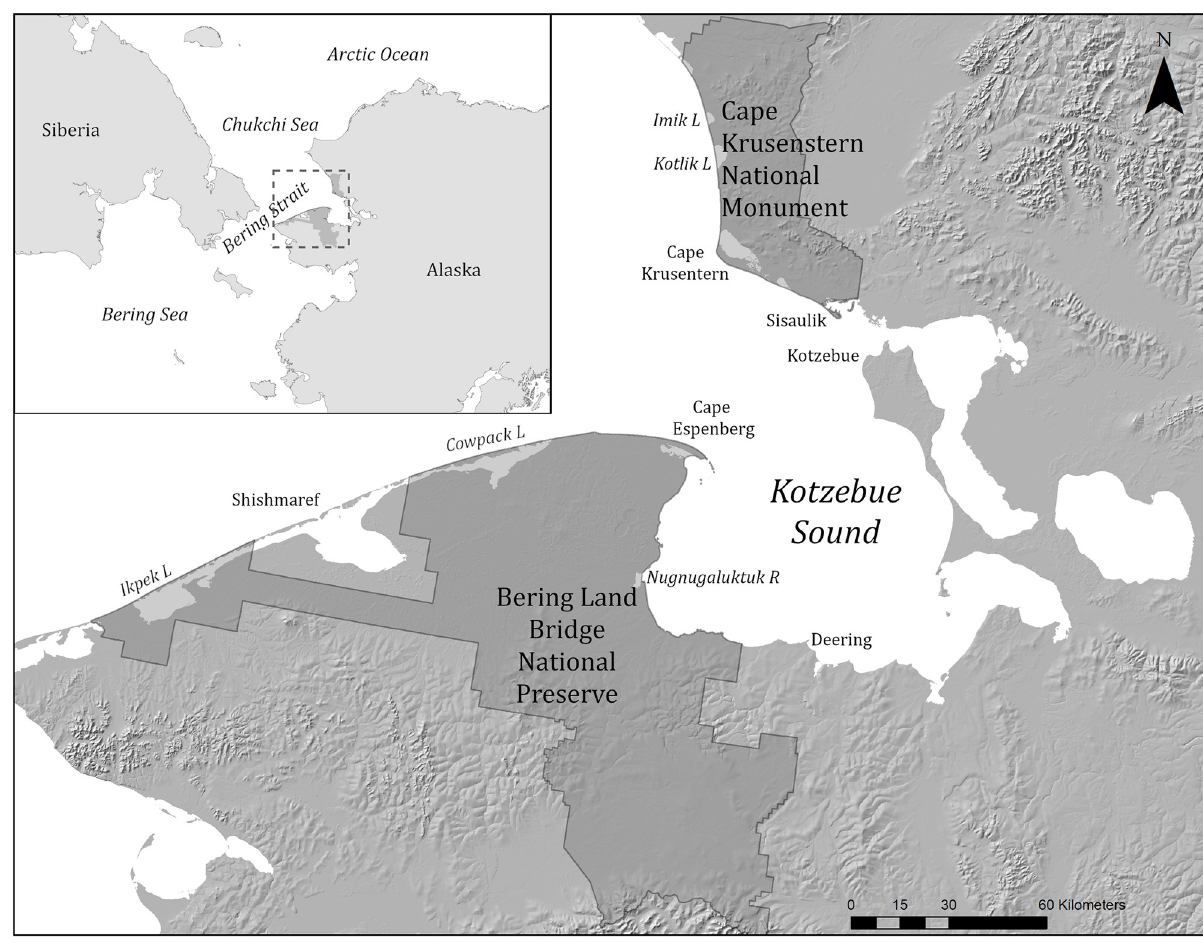
Fig 1. Study area map. 1A. Location of the Chukchi Sea. 1B. Location of the two parks and relevant coastal landmarks. Elevation data USGS 30 ARC- second Global Elevation Data, GTOPO30. Research Data Archive at the National Center for Atmospheric Research, Computational and